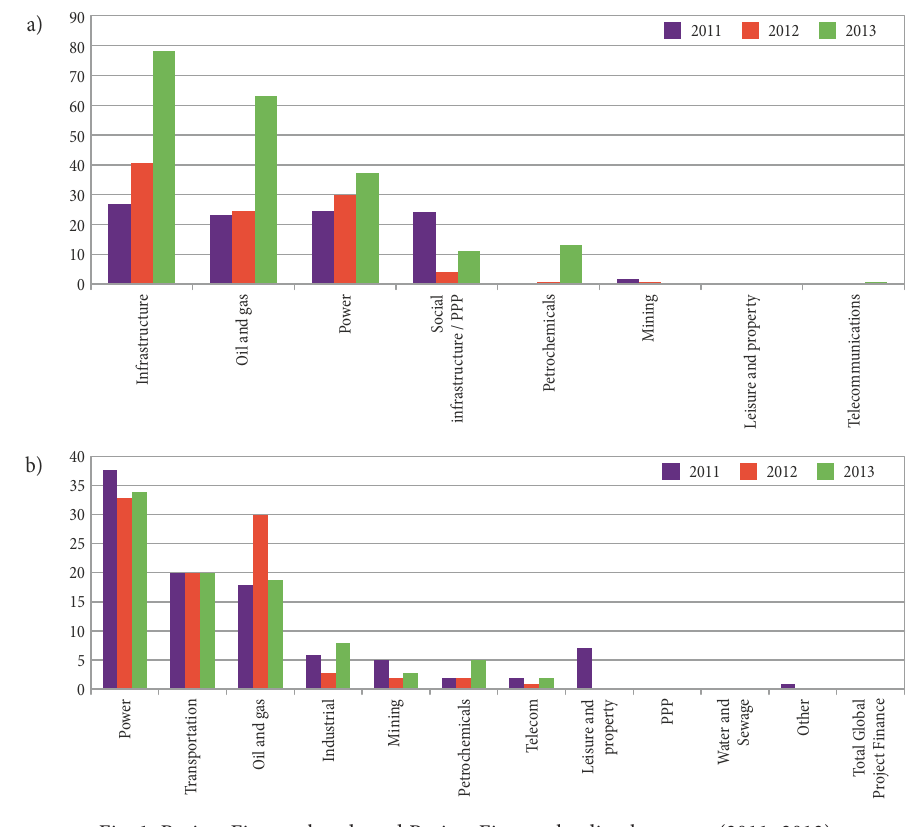
Fig. 1. Project Finance bonds and Project Finance lending by sector (2011–2013) Source : Esty et al. 2014. Table 1. Project Finance Bonds by Sector ($ million)